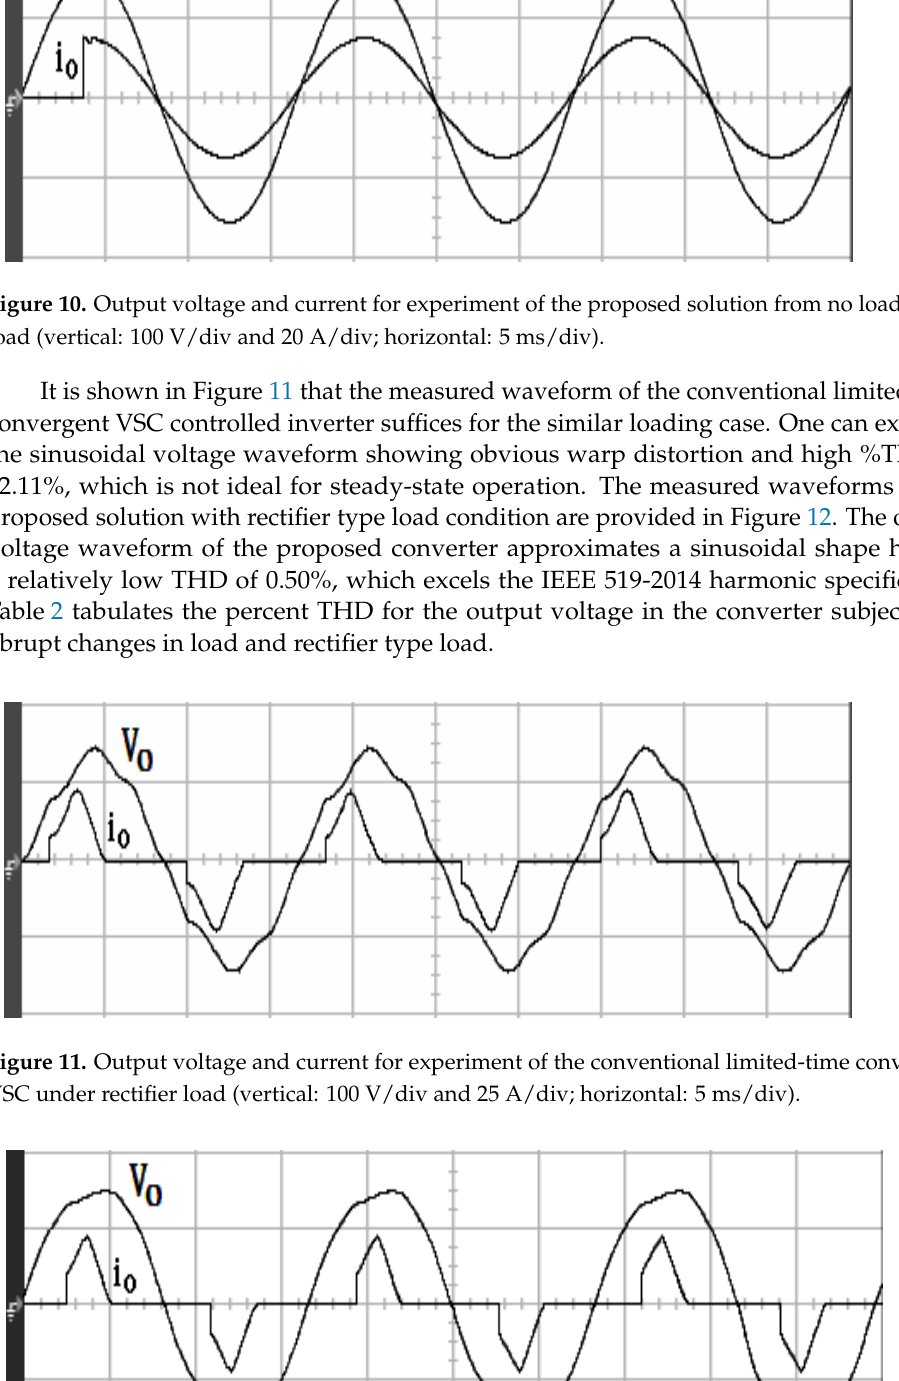
Figure 12. Output voltage and current for experiment of the proposed solution under rectifier load